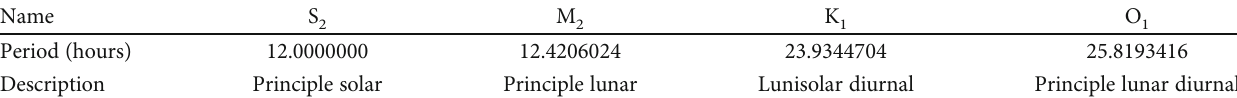
Table 2: Information about tidal constituents commonly used for borehole tidal response